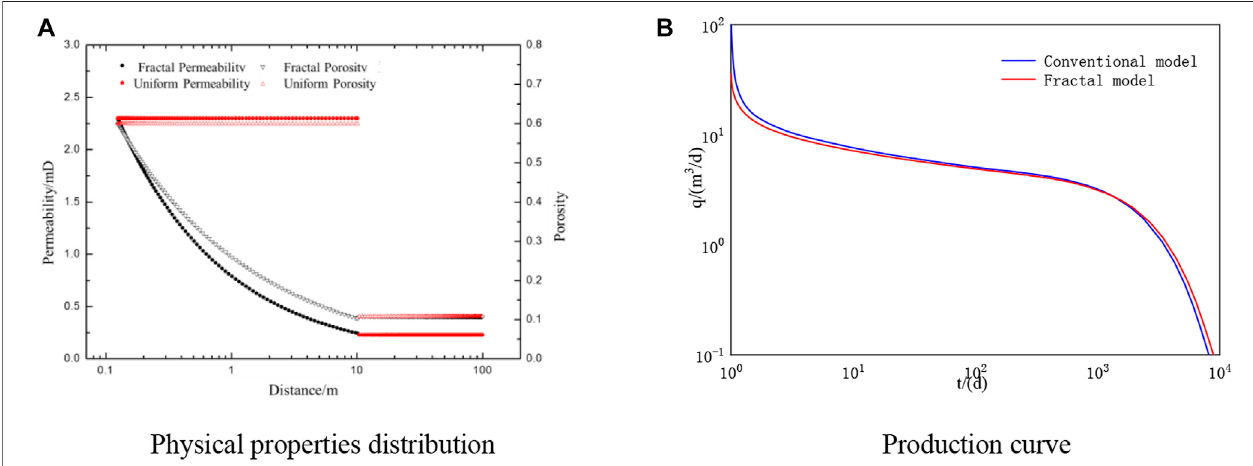
FIGURE 4 | Physical properties distribution and production in stimulated unconventional reservoirs. (A) is the physical properties distribution, (B) is the production curve.